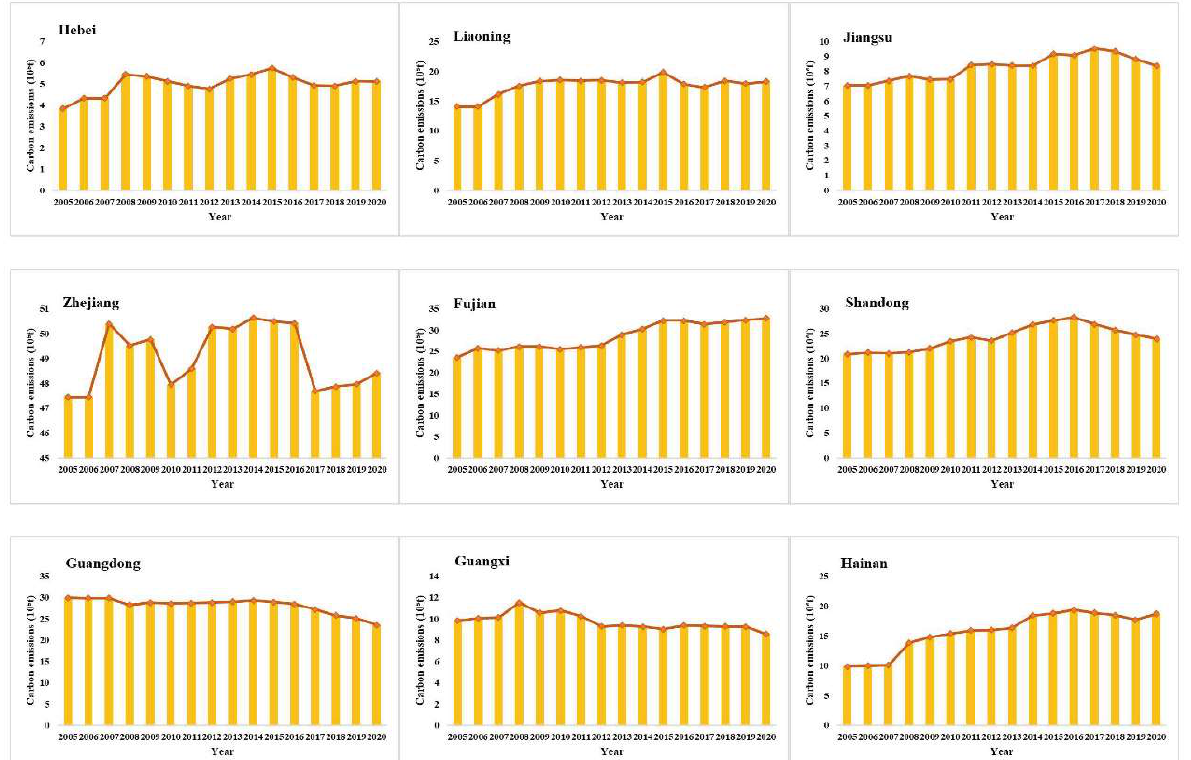
Figure 2. Changes in carbon emissions from the marine fishery industry in coastal provinces from 2005 to 2020. 2005 to